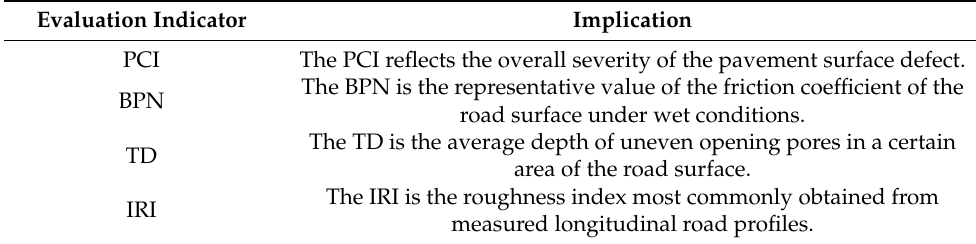
Table 5. Evaluation indicators of road